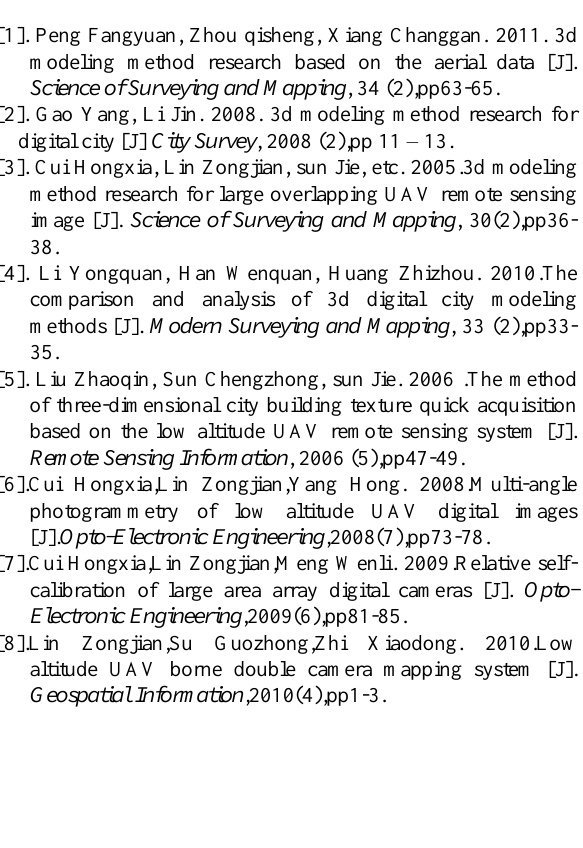
Figure 5. 3d scene reconstruction in